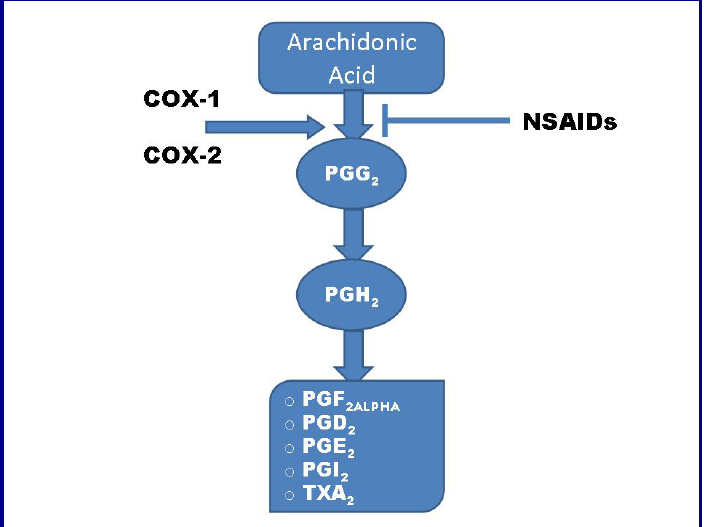
Figure 5. Schematic representation of the conversion of arachidonic acid to prostaglandins and other